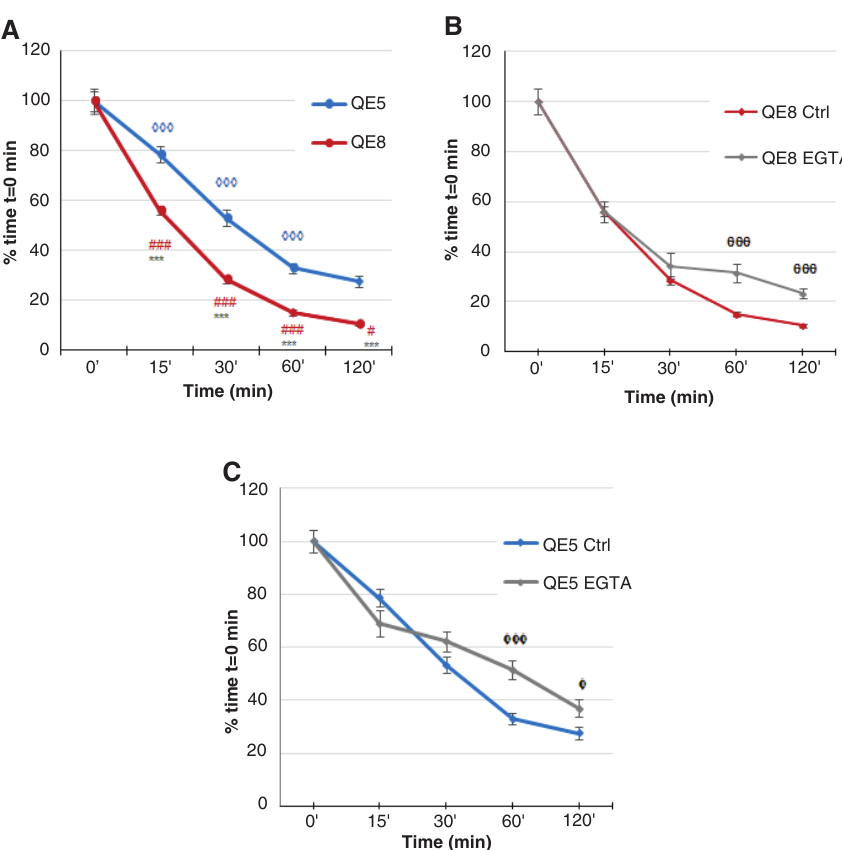
Figure 3. Initial aggregation kinetics of HNK-1 +ve midgut ENS cells are stage and cadherin dependent. Aggregation was indicated by decrease in particle count and is expressed as % of time t=0 min. A . QE5 and QE8 ENS cells aggregated continuously, with particle count at each time point significantly less than at the previous time point (0 min vs 15 min, 15 min vs 30 min, 30 min vs 60 min and 60 min vs 120 min) ( ◊◊◊ p<0.001 for QE5; # p=0.0455, ### p<0.001 for QE8), except for QE5 at 60 min vs 120 min, where the particle counts were not significantly different. In addition, aggregation was greater for QE8 ENS cells compared to QE5 ENS cells (*** p<0.001 QE8 vs QE5 at each time point), consistent with a developmentally increasing adhesive capacity. B . With EGTA, early aggregation (0 min, 15 min and 30 min) of QE8 ENS cells proceeded rapidly and was not significantly different from particle counts in control medium at the same time points. At later time points (60 min and 120 min) particle counts with EGTA were significantly greater than from the same time points in control medium ( θθθ p<0.001 EGTA vs Ctrl). This strongly indicates that early aggregation events in these assays are largely calcium-independent but after about 30 min aggregation is dependent on cadherin function. C . QE5 ENS cells showed a similar early rate of decline in particle number with EGTA medium at matched time points of 0 min, 15 min and 30 min. Later, particle number decline decreased in EGTA ( φφφ , p<0.001 EGTA vs Ctrl at 60 min; φ p=0.0225, EGTA vs Ctrl at 120 min;). This indicates that for QE5 ENS cells early aggregation is largely calcium-independent but further aggregation requires cadherin function. Error bar=SEM.